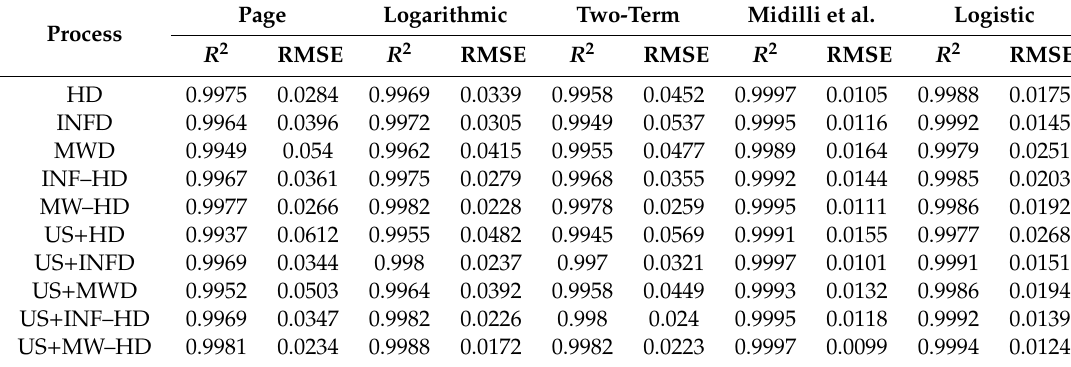
Table 5. Results of the non-linear regression analysis of different mathematical drying models.